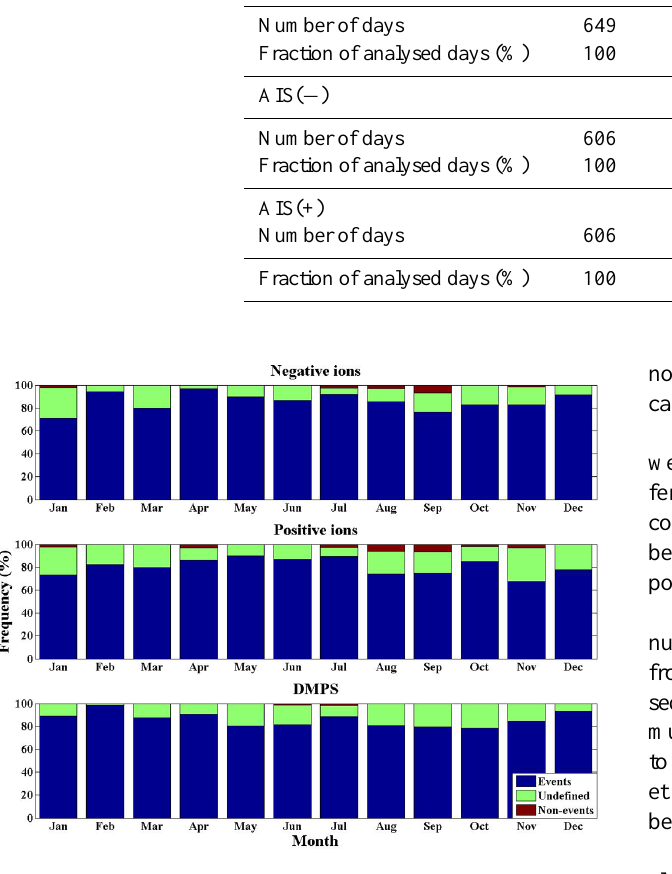
Fig. 9. Monthly distribution of particle formation, undefined and non-event days based on the DMPS (lower panel), positive (middle panel) and negative (upper panel) ion data